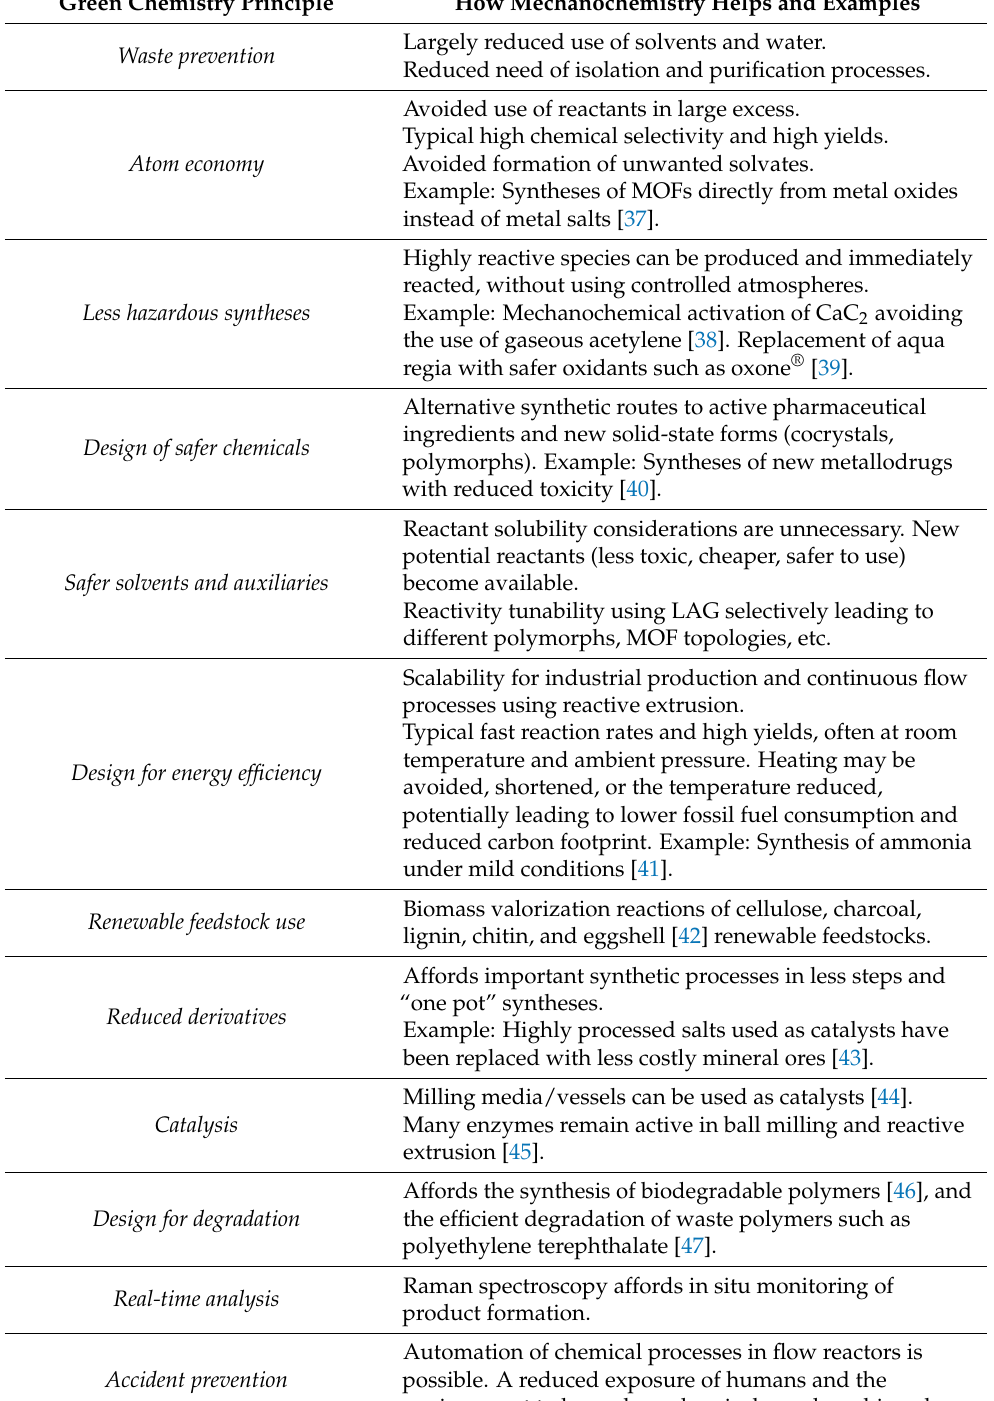
Table 1. The twelve principles of green chemistry and how they can be fulfilled through mechanochemistry, including selected